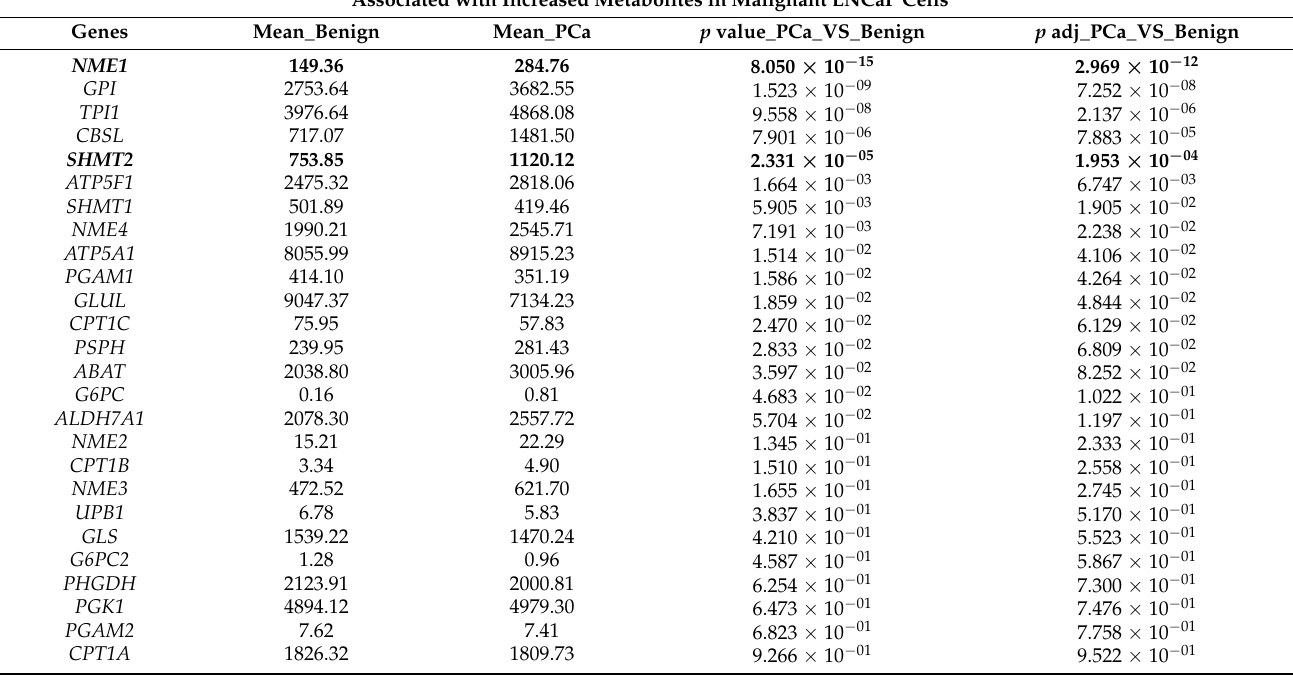
Table 1. Genes encoding enzymes related to metabolites specifically increased in malignant LNCaP. -Eight genes displayed increased expression in PCa compared to paired benign tissue samples in the cohort of 16 prostate cancer patients [25], NME1, GPI, TPI1, CBSL, SHMT2, ATP5F1, NME4 and ATP5A1 . NME1 and SHMT2 genes (in bold) were selected as markers of poor prognosis based on confirmation of overexpression in tumors in additional publicly available datasets and association with shorter disease-free survival (Figure 6).